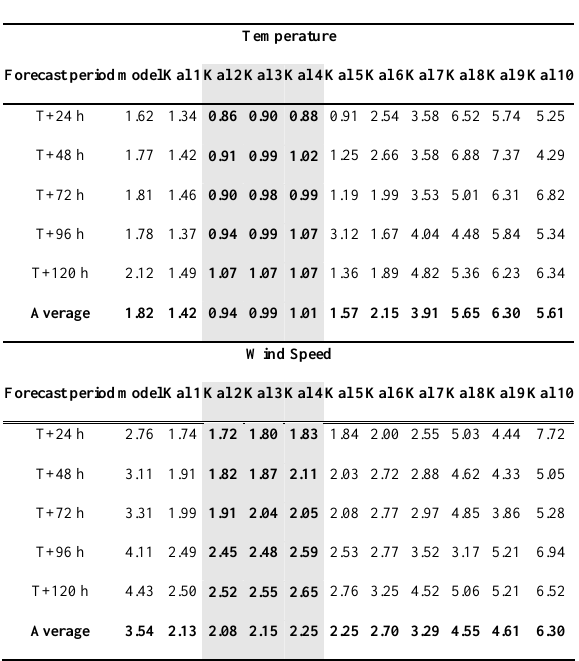
Table 4. Absolute Biases of direct model output and Kalman filters – Case II. TABLE 4 . Absolute Biases of direct model output and Kalman filters – Case